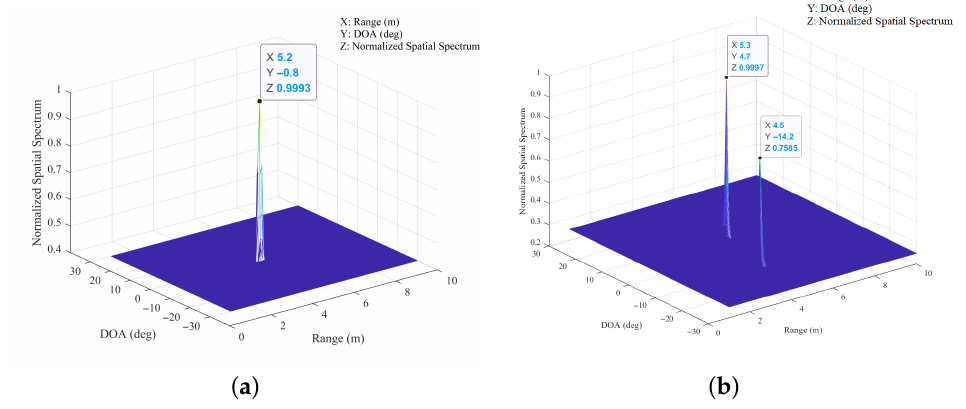
Figure 19. 2D-MUSIC imaging results with a fine grid: ( a ) Single target. ( b ) Two